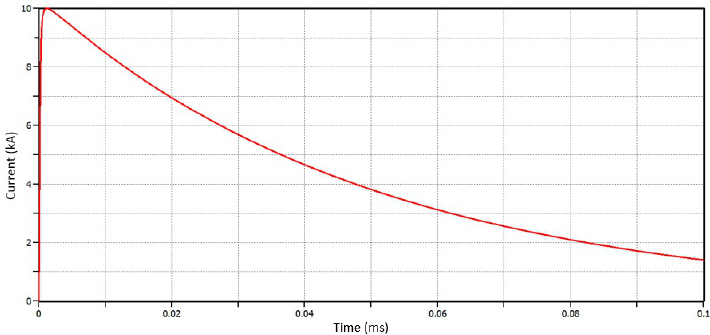
Figure 1. Example of Heidler function in the form of a 1.2/50 lightning waveform with 10 kA